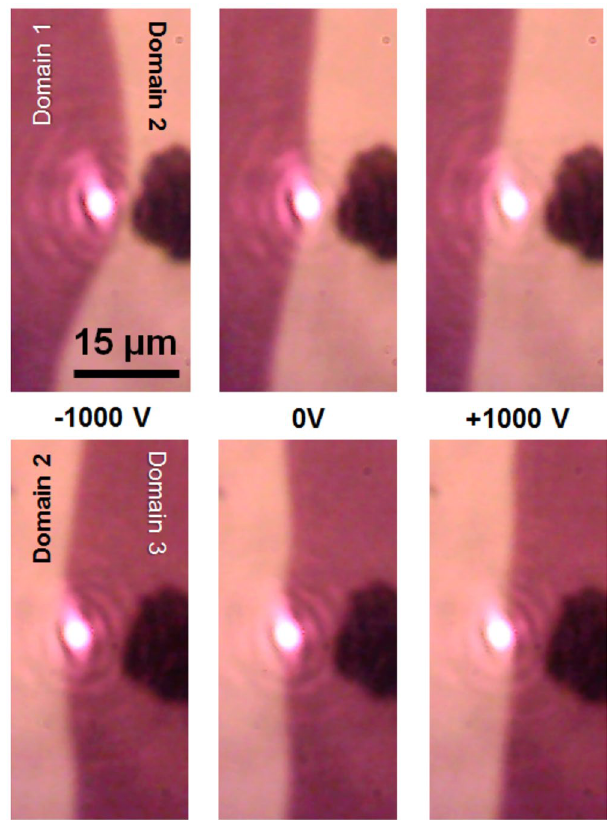
Figure 2. Magneto-optical image of the domain structure in the presence of local electric field. The domain wall is shifted from the equilibrium position due to the flexomagnetoelectric effect when the tip is charged. Dark and bright colors correspond to the opposite magnetization directions of the domains. Top and bottom rows demonstrate deformation of the left and right DWs of the same domain (the brighter one, domain 2). The tip voltages are − 1000 V, 0 V, and + 1000 V. The external in-plane magnetic field is 12 mT and is directed perpendicular to the DW. Out-of-plane field is about 0.15 mT. Bright spot in the middle is laser spot of 2 μ m in diameter; laser wavelength is 660